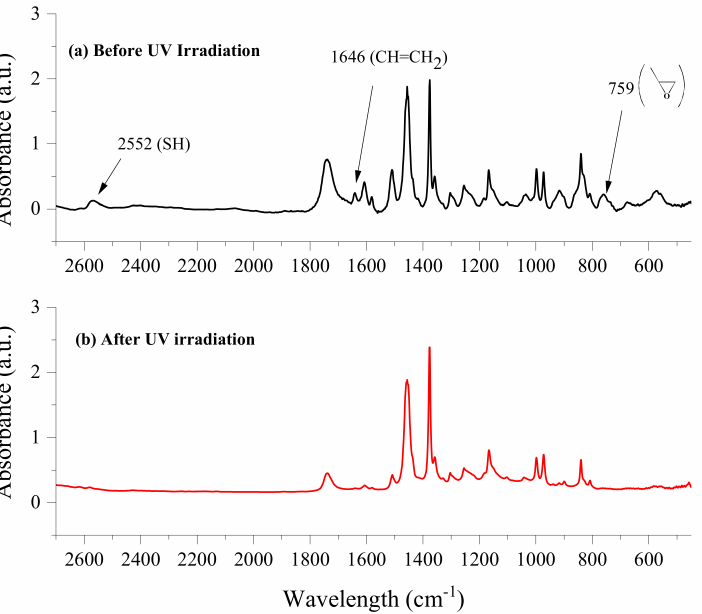
Figure 3. Comparison of the FTIR spectra of the ETE formulation with 40 mol % of TES: ( a ) before and (b ) after being irradiated with UV light of 40 mW/cm 2 and 85 ◦ C for 600